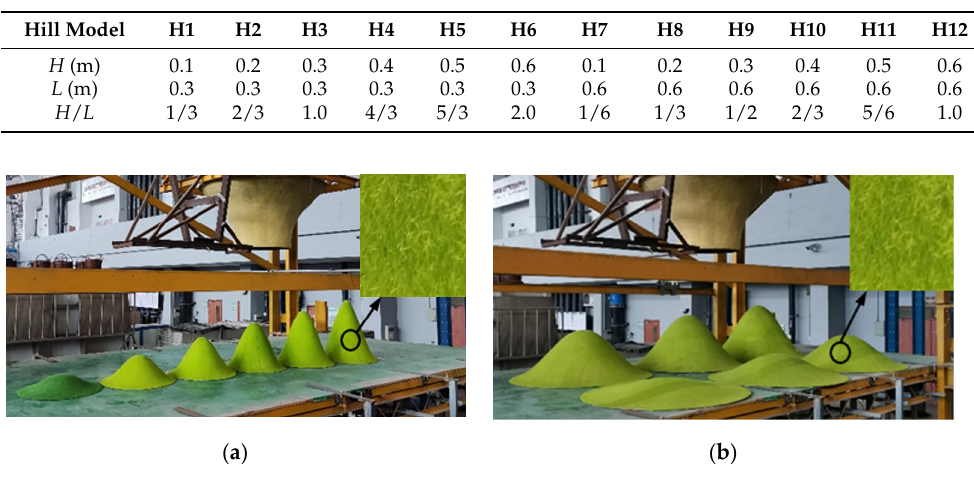
Figure 3. Photos of hill models: ( a ) L = 0.5 D jet ; ( b ) L = 1.0 D jet .